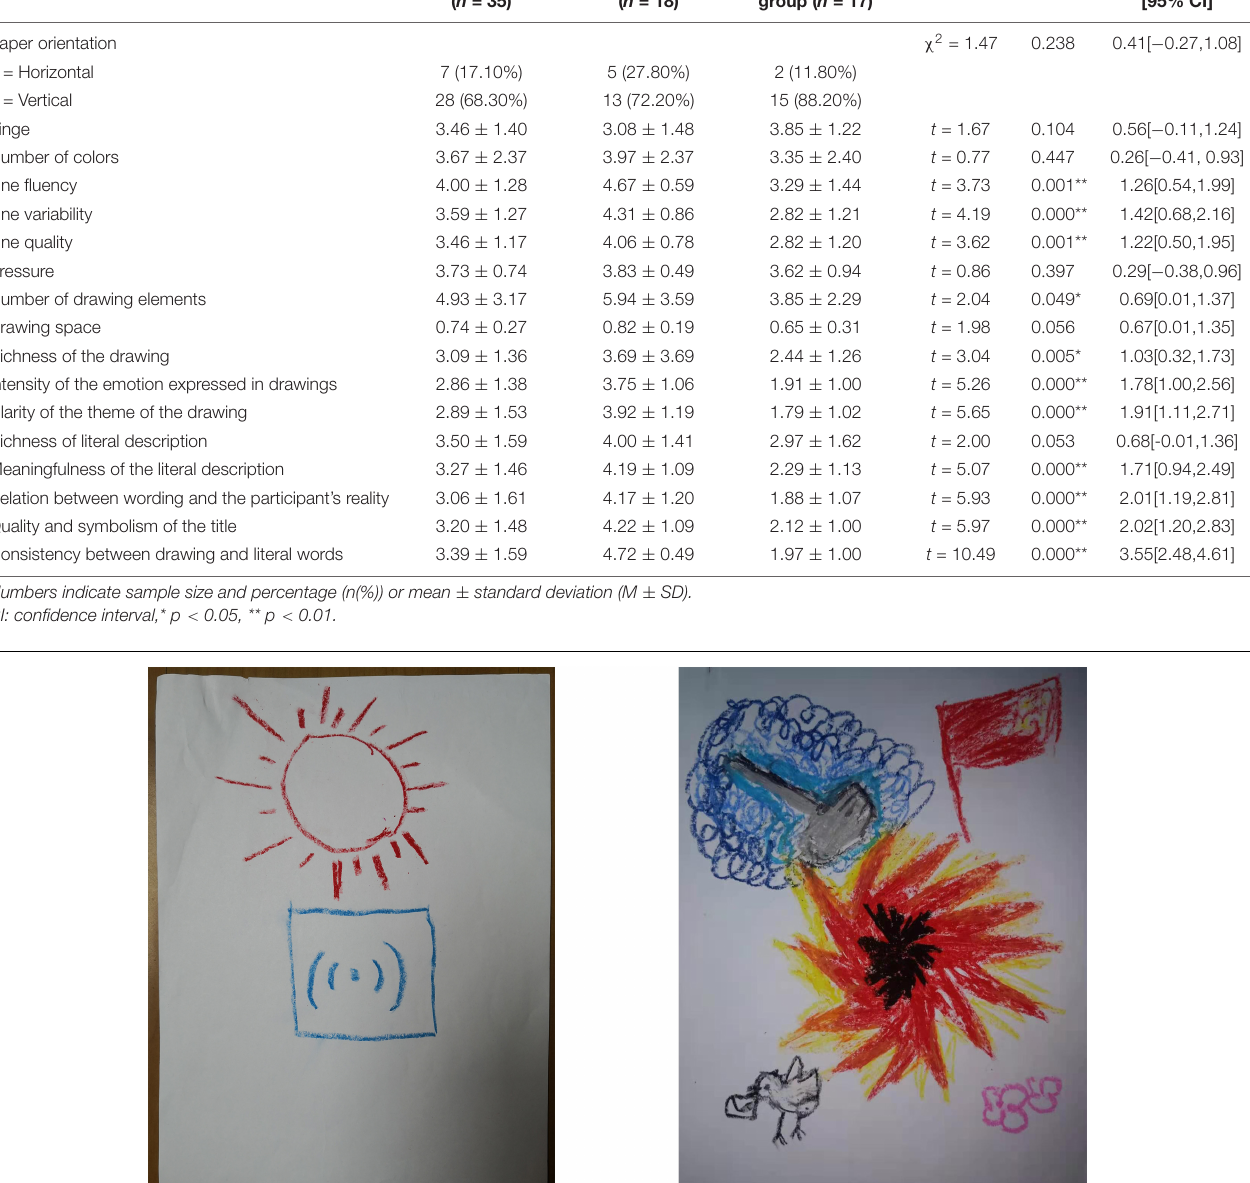
and orbitofrontal areas (Ch1, Ch3, Ch4, Ch6, Ch8, Ch9, Ch10, Ch11, Ch12, and Ch14) whereas those in the control group had significant negative activation in a part of the left Broca’s area (Ch16). We also found significant group differences in the drawing content including in the line variability, the weight of strokes, the number of drawing elements, the richness of the